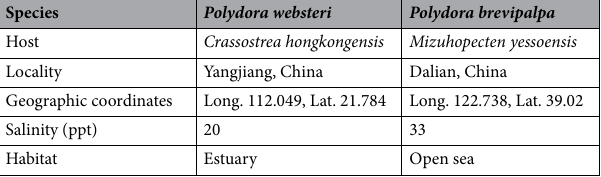
Table 3. Sampling